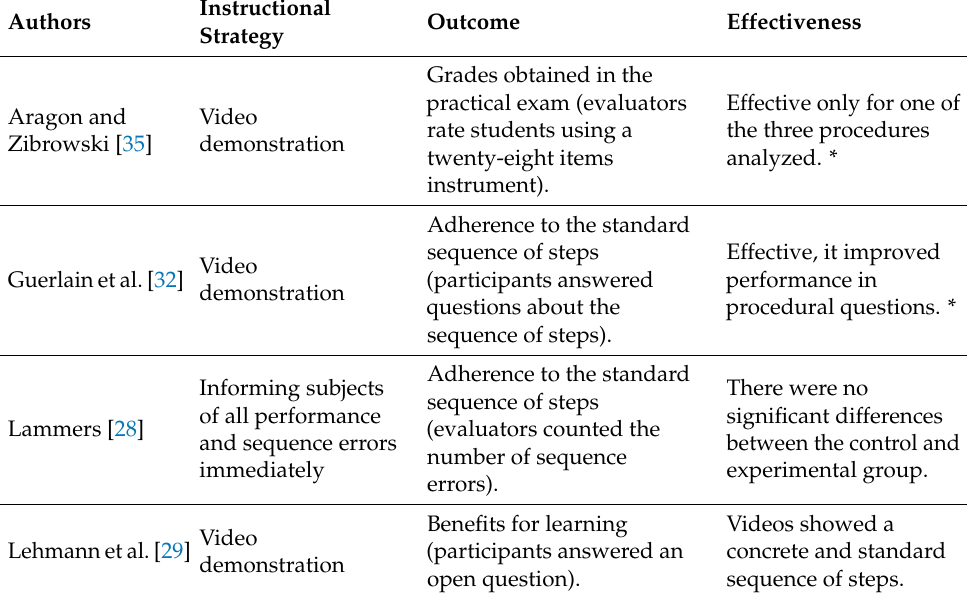
Table 1. Teaching the standard sequence of steps: strategies, outcomes and